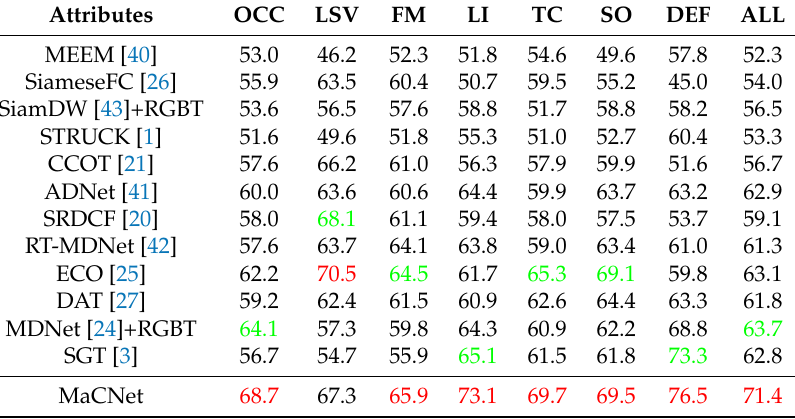
Table 4. Attribute-based SR scores (%) on GTOT dataset [12] against with twelve RGB-T trackers. Optimal and suboptimal results are represented by red and green fonts,